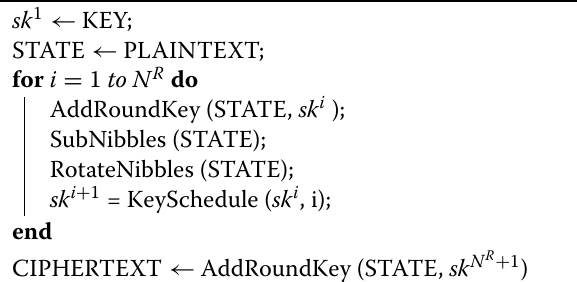
Algorithm 1: The encryption process of KLEIN